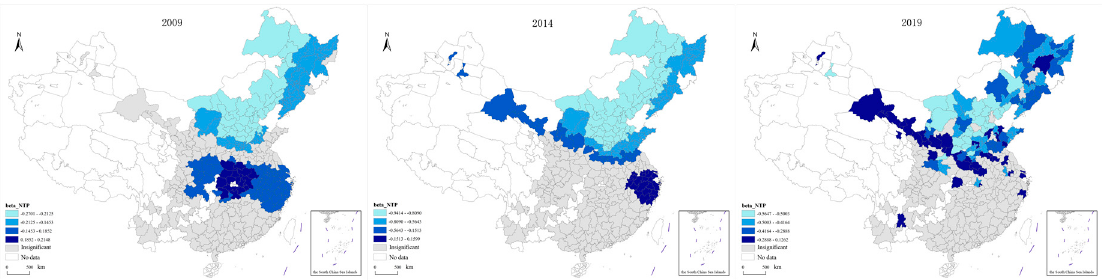
Figure 9. Spatial distribution of number of employees in the transportation industry indicator